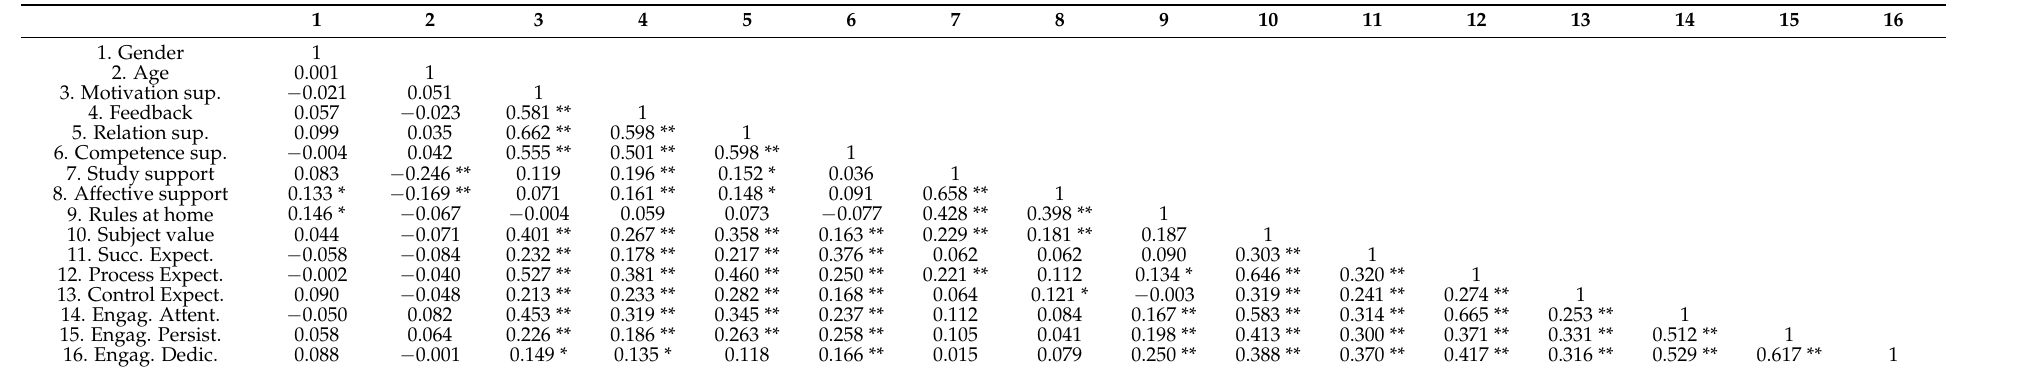
Table 2. Pearson’s bivariate correlations between the constructs considered in M1.